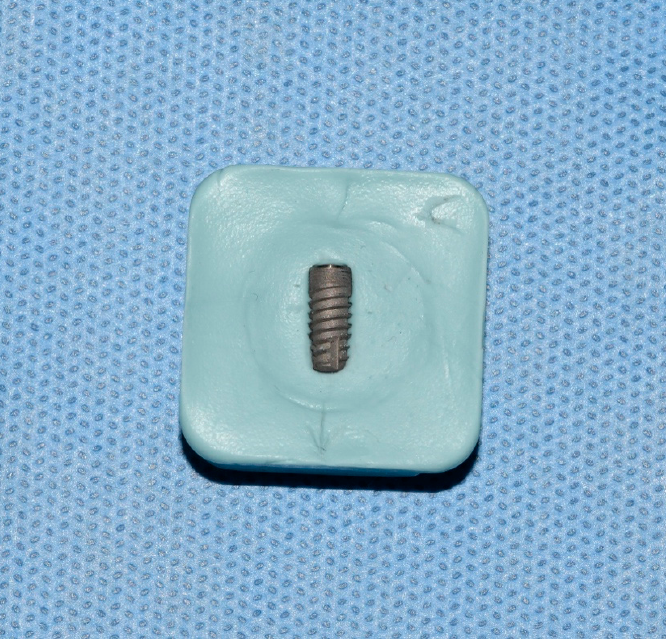
Figure 1. Contaminated dental implant in sterile silicon holder.